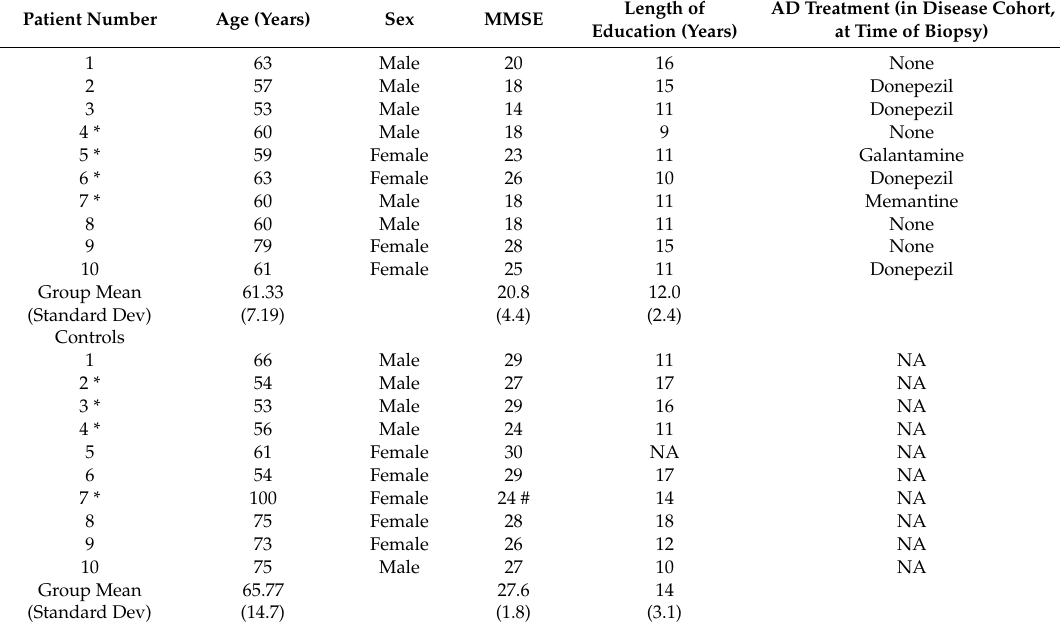
Table 1. Patient Demographic Information and contemporary treatment